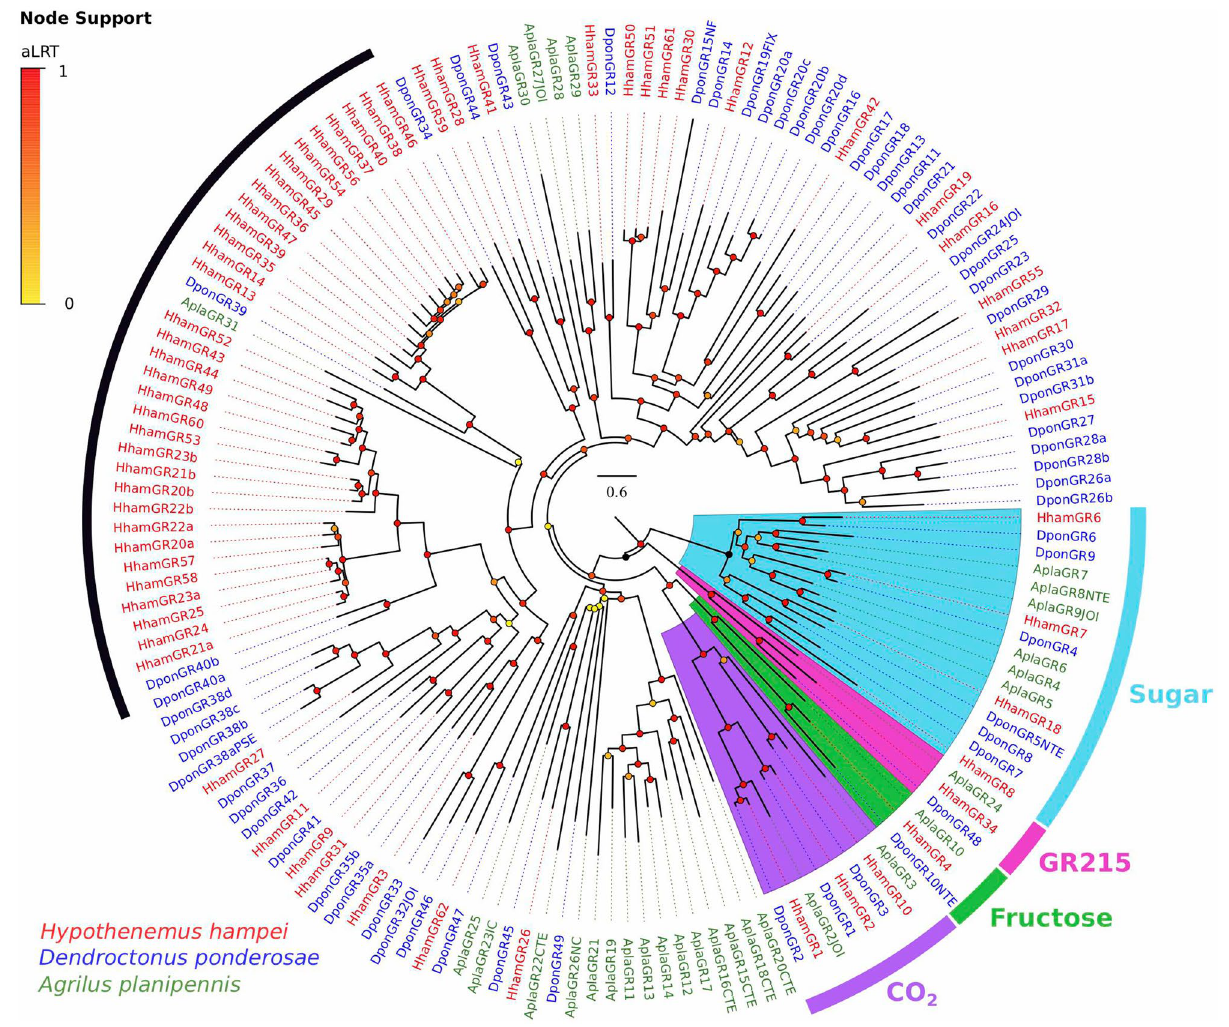
Figure 3. Phylogeny of gustatory receptor (GR) family. GR protein sequences from Hypothenemus hampei (HhamGR), Dendroctonus ponderosae (DponGR) and Agrilus planipennis (AplaGR) were clustered by Maximum-Likelihood tree-building. Branch supports (aLRT; approximate likelihood ratio test) are shown as colored circles (yellow to red transition). Thick colored arcs indicate the clusters for the conserved GRs for fructose, sugar and CO 2 . The remaining GRs are likely bitter receptors. The recently discovered “GR215 clade” is also indicated by a colored arc. The black arc indicates likely GR gene expansions in H. hampei